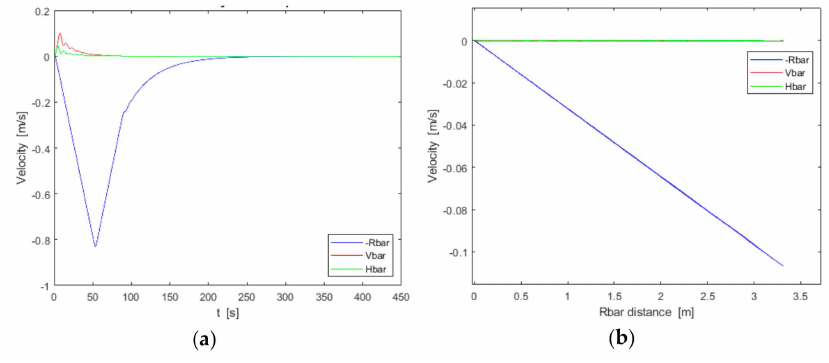
Figure 5. Relative velocity ( a ) along the three axes vs. time, ( b ) in the last 2